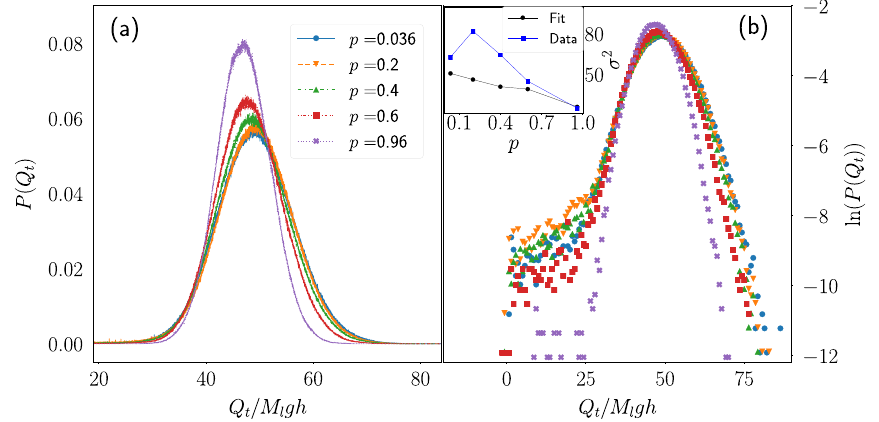
Figure 8. Heat distribution at fixed load mass. ( a ) Pdf of the heat exchanged between the particle and the thermal walls during a time window t = 40 ¯ t c for systems with M l = 1 and several values of p . ( b ) Logarithm of the data shown in ( a ). Inset: Variance of the distribution computed from a Gaussian fit to the data around its maximum (squares) and from the numerical computation using all the heat data (circles).